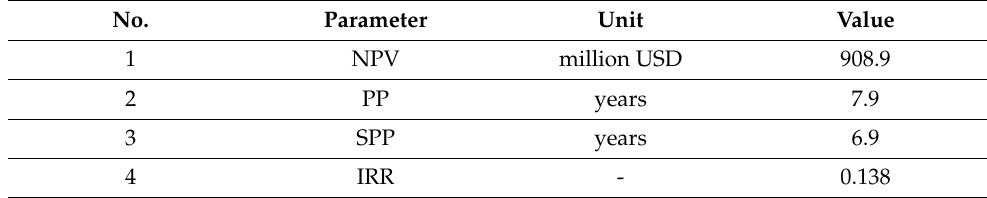
Table 14. The key economic parameters for the